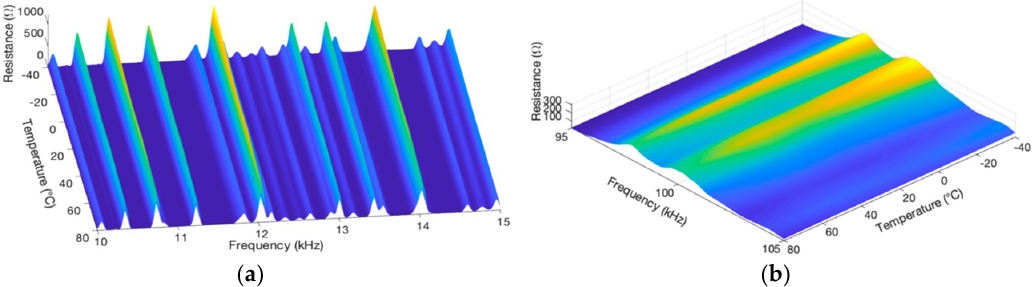
Figure 9. Trendlines of the vertical shift of the impedance (real part) pipe-1/PZT-1: ( a ) at low frequency and ( b ) at high frequency.